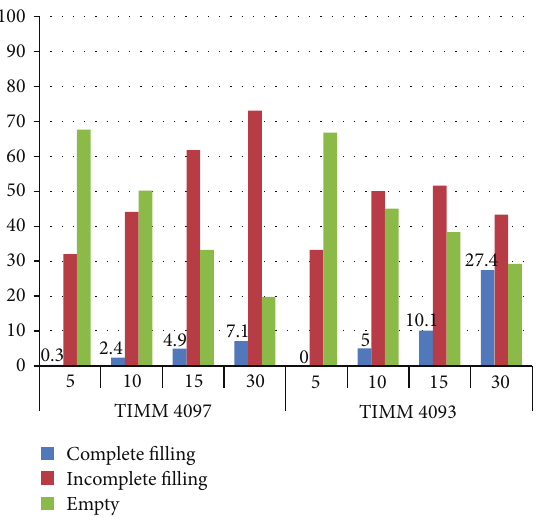
Figure 10: The percentage of bronchi that was “completely full” in mice infected with C. gattii TIMM 4097 on days 10, 15, and 30 after infection was 2.4, 4.9, and 7.1%, respectively, while that of mice infected with C. gattii 4903 was 5.0, 10.1, and 27.4%, respectively. Results revealed that the ratio of “completely full” bronchi in mice infected with C. gattii TIMM 4903 was significantly higher than that of mice infected with C. gattii TIMM 4097 throughout the observation period.